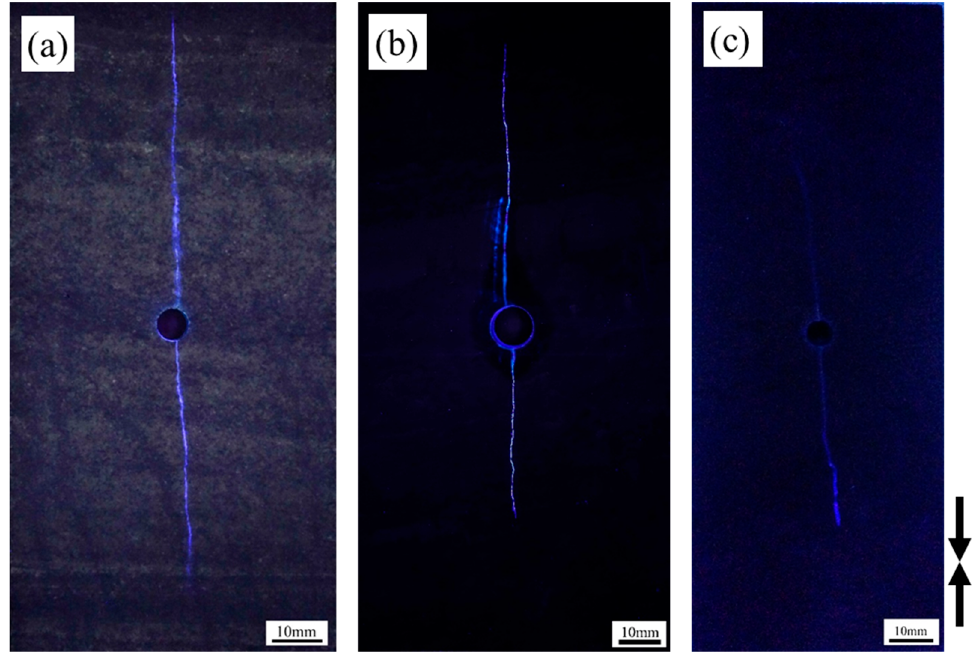
Figure 2. Observation of hydraulically induced fractures under UV light in ( a ) Eagle Ford shale; ( b ) Inai shale; and ( c ) Cretaceous Kushiro shale. The pair of black arrows next to ( c ) represents the loading direction. Two main fractures (bi-wing fracture) along the loading direction were observed. Table 2. Summary of experimental fracturing results and corresponding figures.